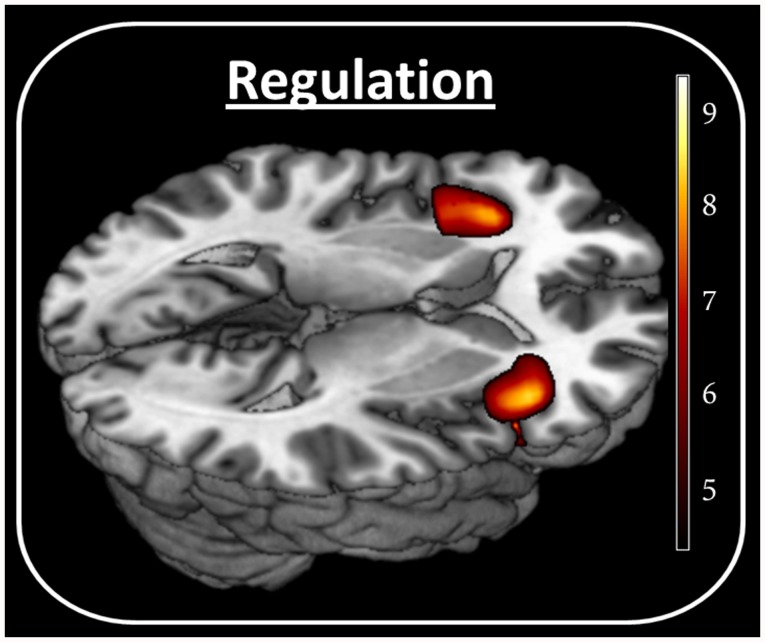
Regulation vs. relaxation.Activation in the SPM contrast ‘upregulation – relaxation’ in the AIC bilaterally for all subjects (right: −36 26 −2, T = 7.85; left: 39 20 −5, T = 7.65). Color bar shows T values.